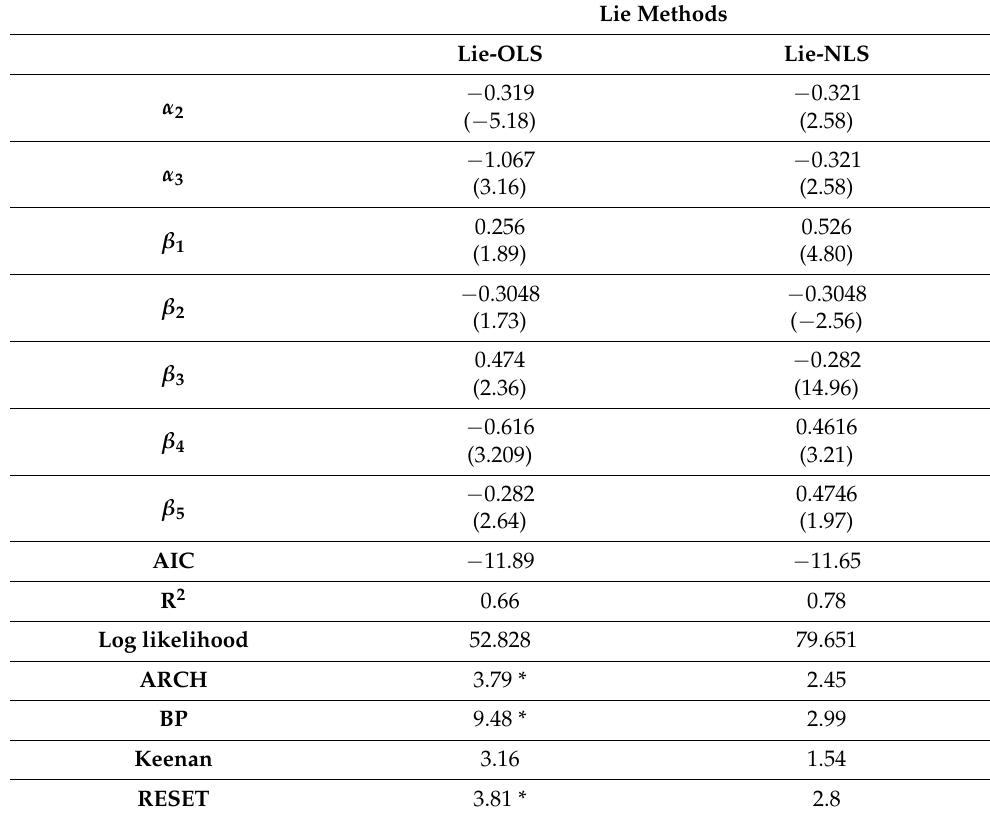
Table 4. Estimations of Lie